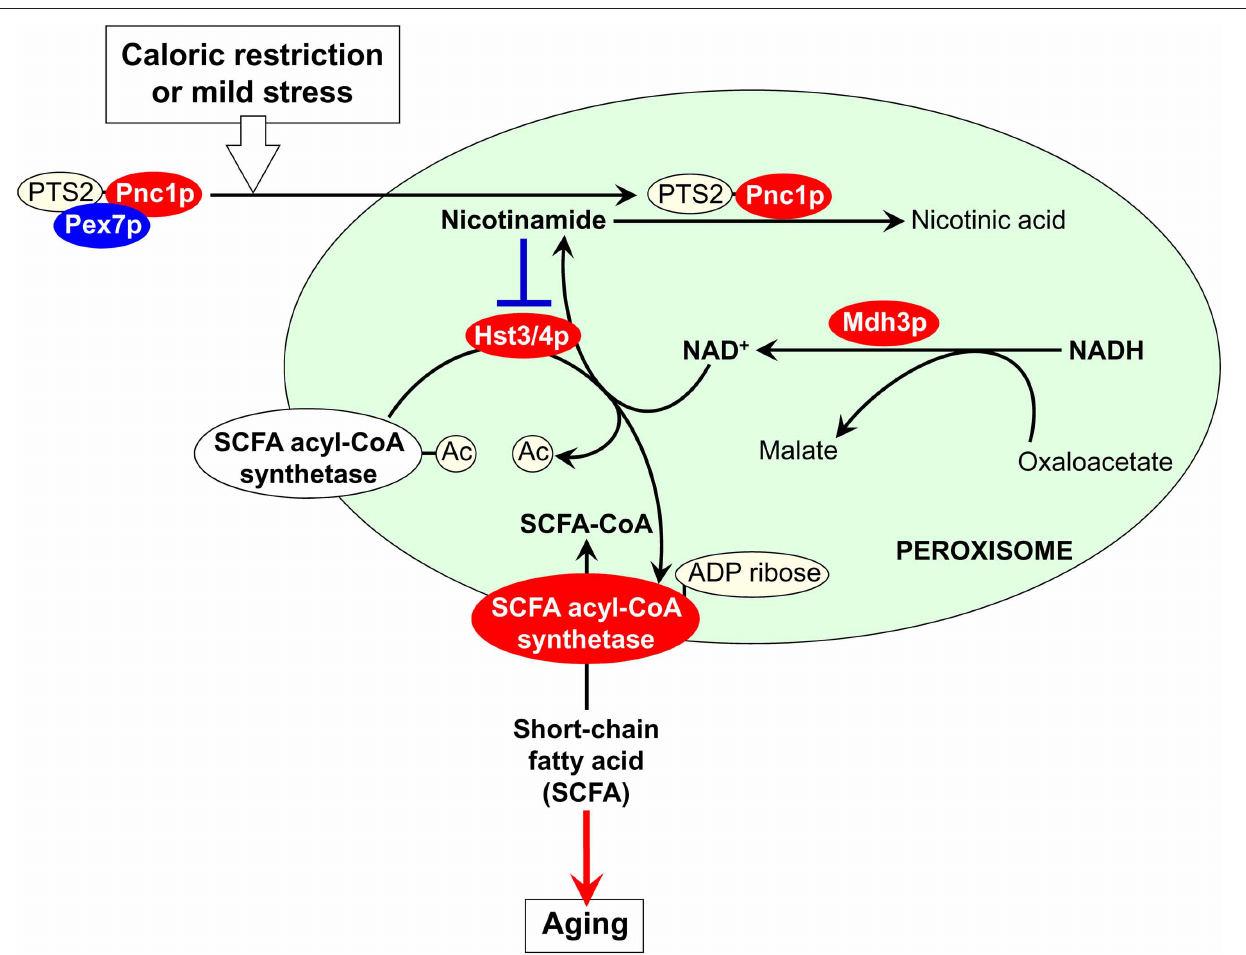
FIGURE 1 | A proposed role for cytosol-to-peroxisome targeting of Pnc1p in regulating longevity of replicatively aging yeast. If exposed to caloric restriction (CR) and other hormetic anti-aging stimuli, yeast cells respond by targeting Pnc1p—a pyrazinamidase/nicotinamidase 1 that converts nicotinamide to nicotinic acid in the NAD + salvage pathway—not only to the nucleus but also to the peroxisome. The delivery of Pnc1p to the peroxisome depends on the peroxisomal targeting signal 2 (PTS2) shuttling receptor Pex7p. Inside the peroxisome, Pnc1p activates the sirtuins Hst3p